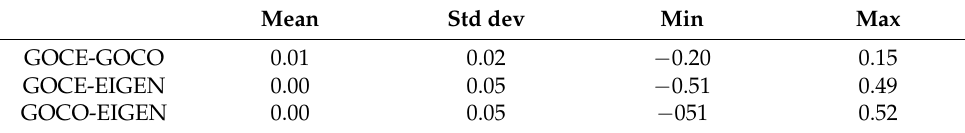
Table 6. Difference (in meters) between computed quasigeoid. Mean Std dev Min Max GOCE-GOCO 0.01 0.02 − 0.20 0.15 GOCE-EIGEN 0.00